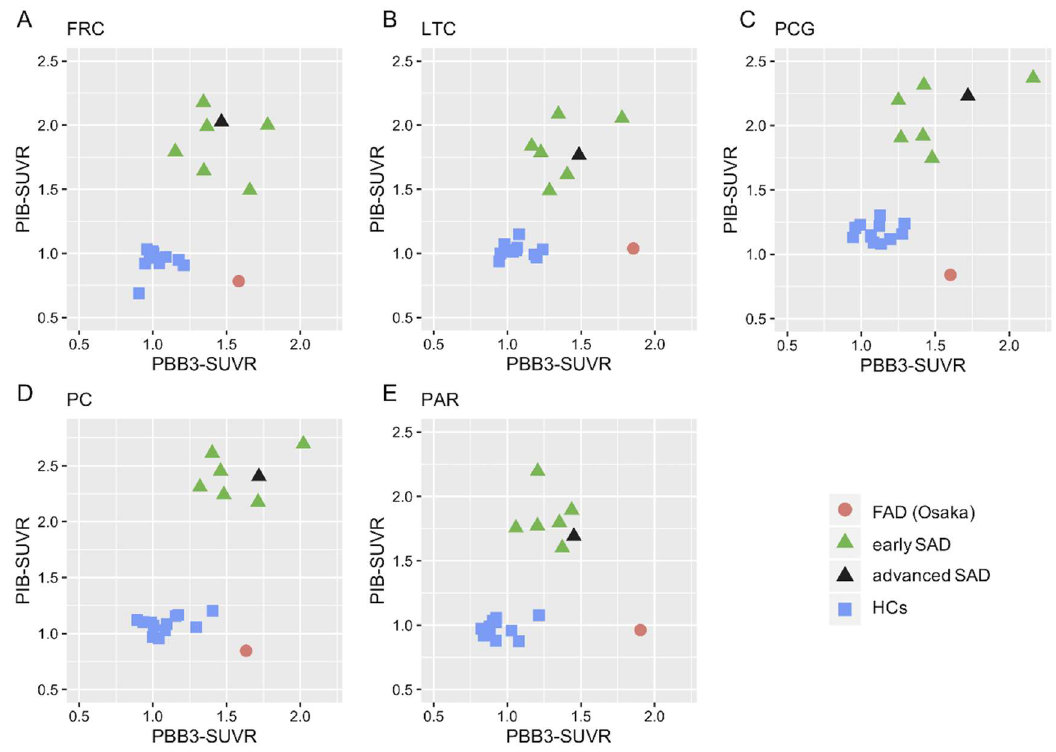
Figure 5. Scatter plot analysis between tau (PBB3-SUVR) and Aβ (PiB-SUVR) accumulation in the frontal cortex (( A ): FRC); lateral temporal cortex (( B ): LTC); posterior cingulate gyrus (( C ): PCG); precuneus (( D ): PC); and parietal cortex (( E ): PAR) in a patient with familial Alzheimer’s disease with Osaka mutation (FAD (Osaka)), patients with early and advanced sporadic Alzheimer’s disease (SAD) and healthy controls (HCs). The FAD (Osaka) patient showed a distinguishing pattern with highly elevated PBB3 uptake and subtle uptake of PiB in all regions. In contrast, the SAD patients exhibited highly elevated accumulation of both PBB3 and PiB, whereas both were negligible in HCs.